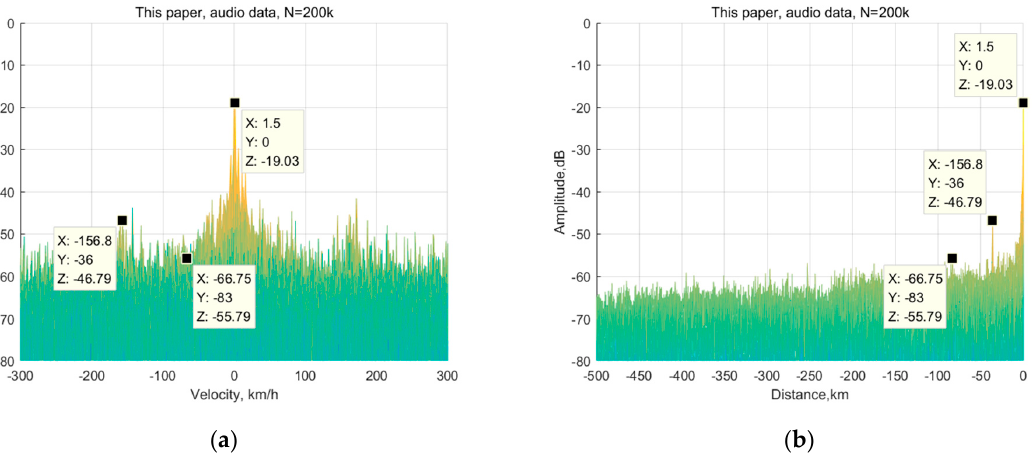
Figure 19. Integration results obtained with proposed method for the audio signal: N = 2 × 10 5 ; ( a ) Doppler dimension; ( b ) Range dimension.